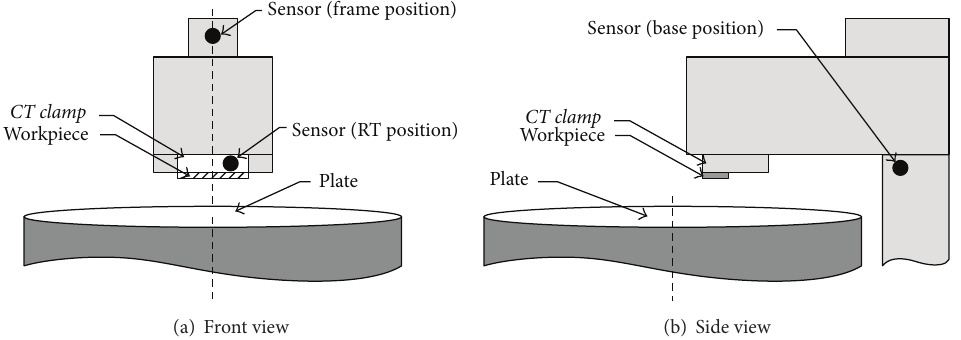
Figure 5: Schematic view of sensor position tests.